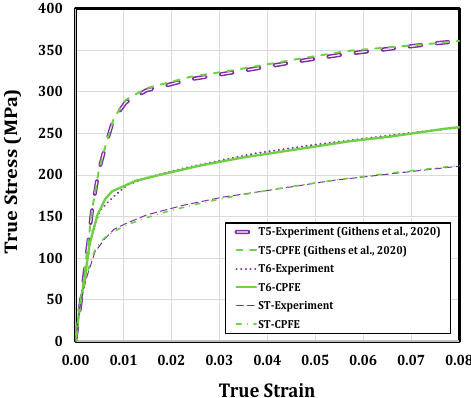
Figure 24. Comparison of the stress ‐ strain curves of WE43 with different heat treatment conditions of ST, T5, and T6 subjected to uniaxial tension along the rolling direction: CPFE simulation versus the experimental results (After Ganesan et al. [8]).